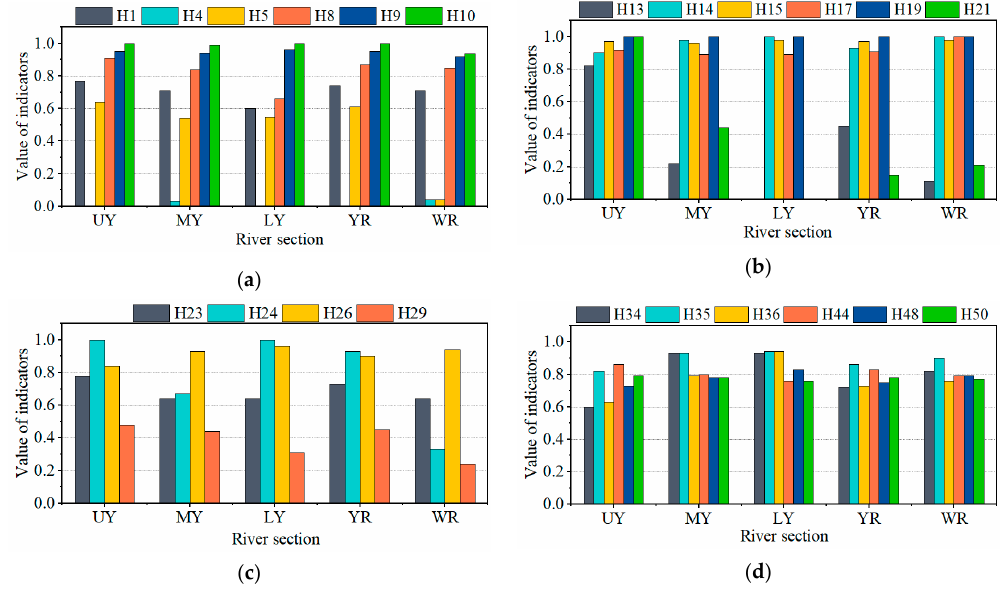
Figure 3. Membership degree values of happy river indicators for di ff erent reaches of the Yellow River and the Wei River: ( a ) indicators for safe operation index (SOI) dimension; ( b ) indicators for sustainable supply index (SSI) dimension; ( c ) indicators for ecological health index (EHI) dimension; ( d ) indicators for harmonious development index (HDI) dimension. The codes of the indicators have the prefix ‘H’ (see Table 1), the labels “UY”, “MY”, and “LY” refer to the upper, middle, and lower reaches of the Yellow River, respectively, whereas “YR” and “WR” refer to the Yellow River and Wei River, respectively.